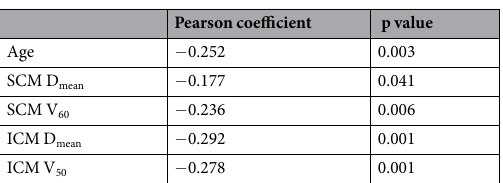
Table 7. Pearson coefficient of MDADI and variable